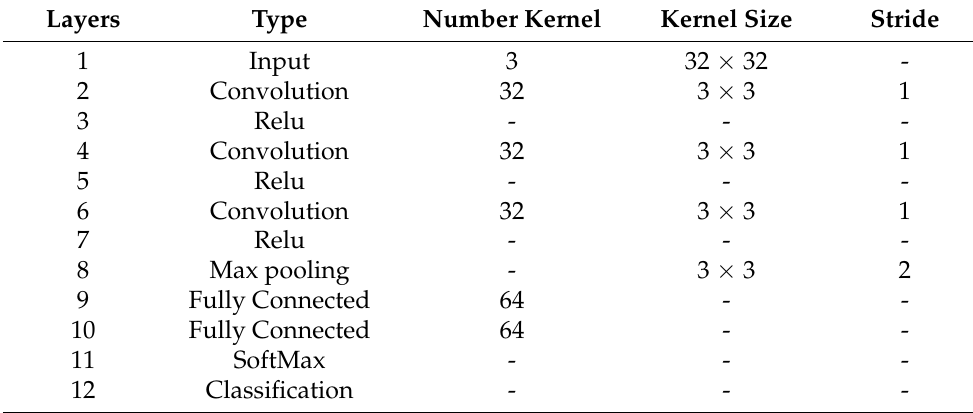
Table 3. CNN model structure.